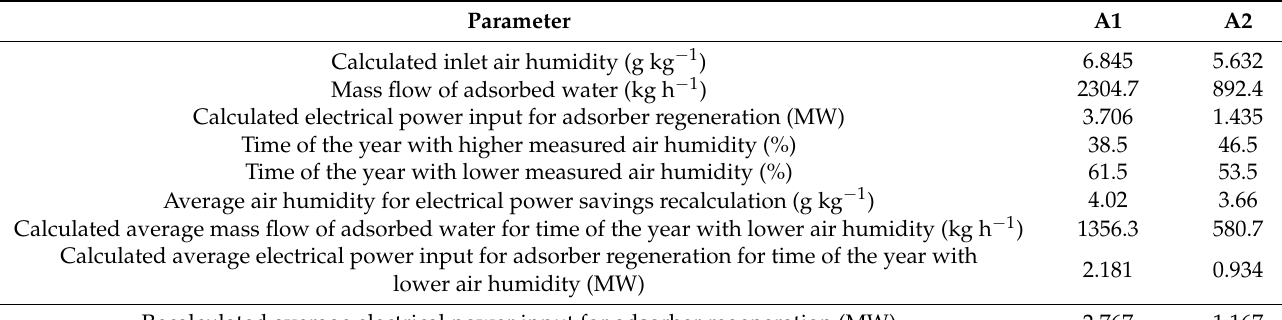
Table A14. Recalculation of power input for adsorber regeneration without ACH employing ambient air humidity dataset presented in Figures